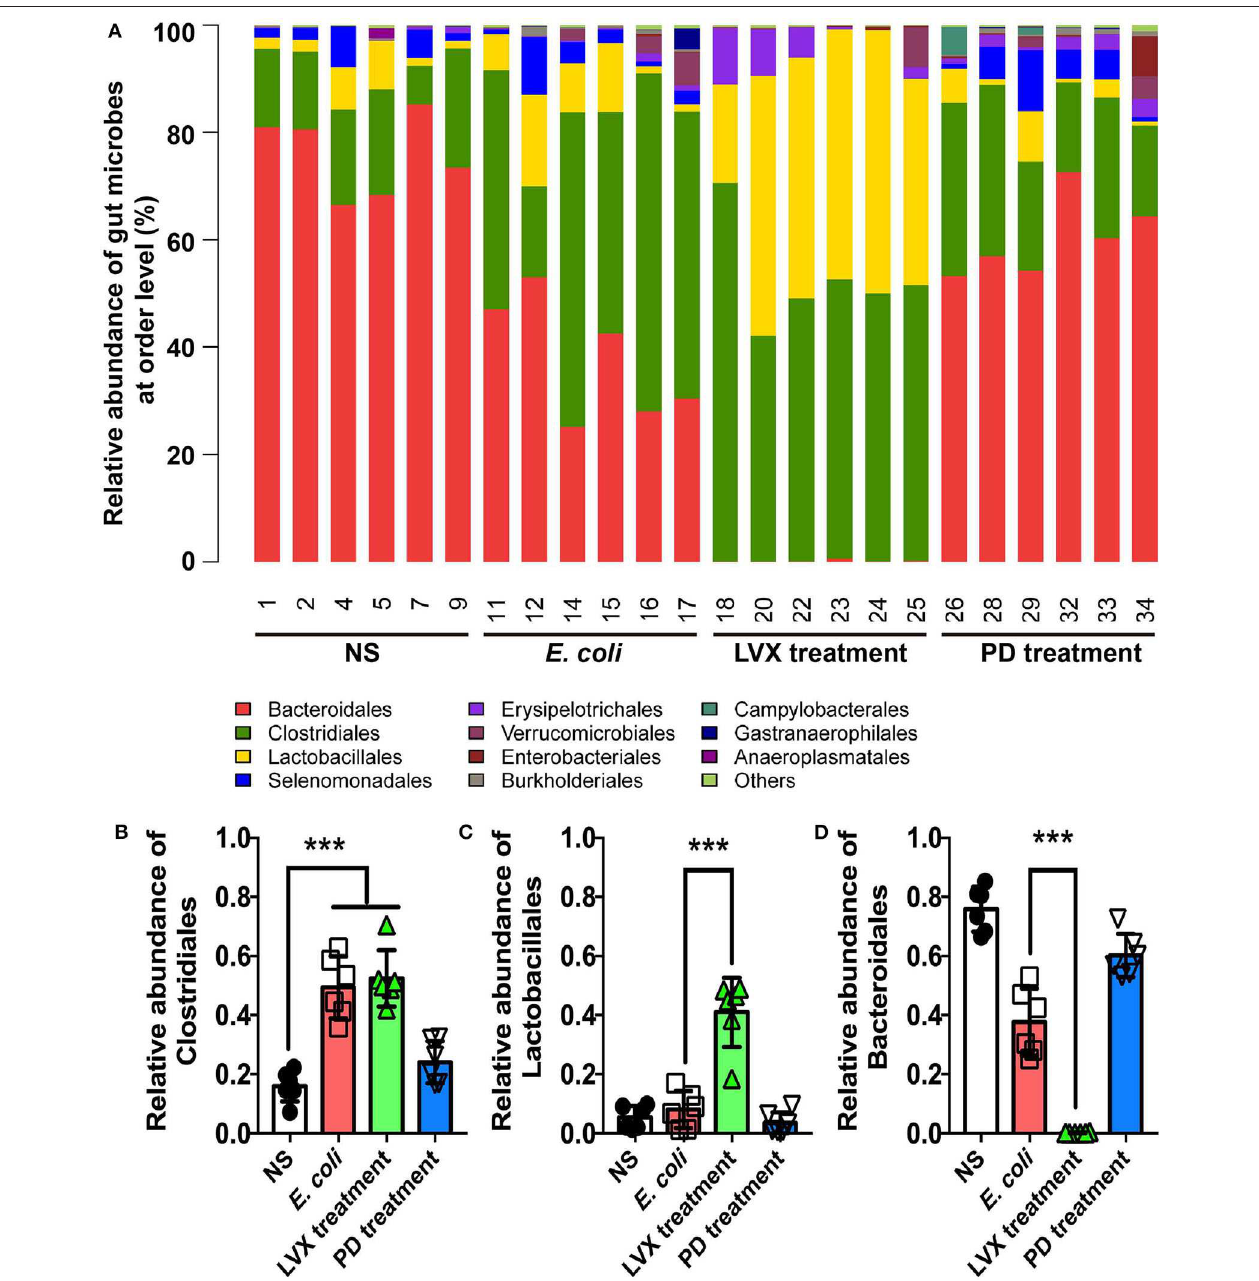
FIGURE 6 | Comparison of main genera in intestine between PD and LVX treatment. (A) Distribution of bacterial taxa under PD or LVX treatment at the order level. (B) Relative abundance of Bacteroidales , Lactobacillales, and Clostridiales under PD or LVX treatment. Results showed the mean ± SD (*** P < 0.001, n = 6).